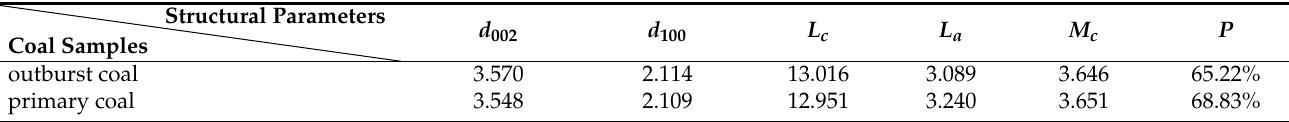
Table 5. XRD microstructure parameters of coal